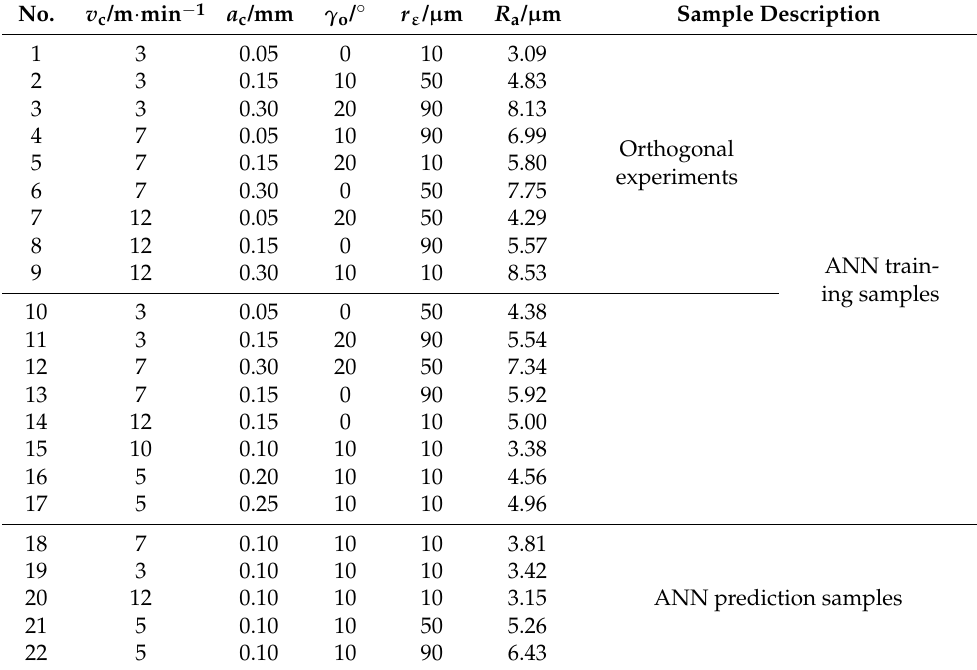
Table 3. Machined surface roughness at different cutting